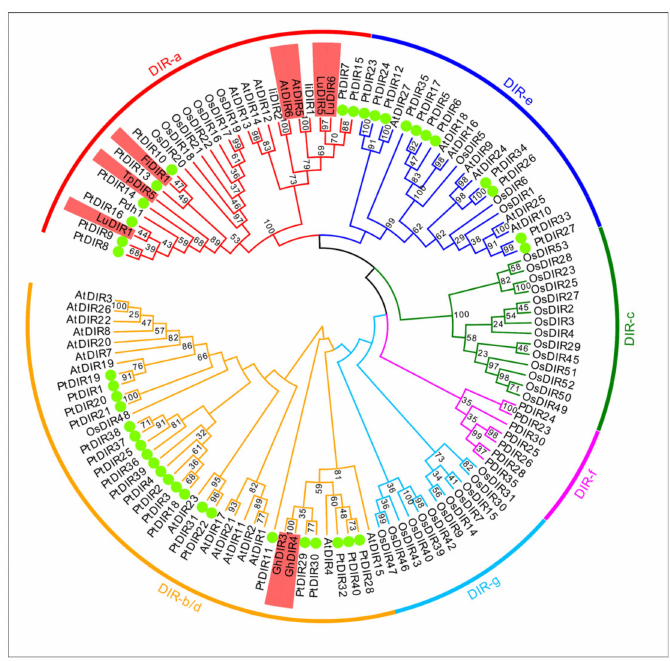
Figure 1. Phylogenetic relationship between P. trichocarpa and other plant species. PtDIRs are labeled with a green circle. The DIR genes that precisely control the stereoselective coupling of alcohol monomers in the formation of (+) or ( − ) pinoresinol are highlighted with a red background. A comparison of PtDIR protein sequences shows that the protein similarity ranges from 3–95%, indicating that some PtDIR proteins may differ significantly and show func- tional diversity. In the DIR-a subfamily, the sequence similarity of PtDIR proteins is exceptionally high, ranging from 52–95%, followed by the DIR-e and DIR-b/d subfamilies, in which it ranged from 27–88% and 6–85%, respectively (Figure 2).